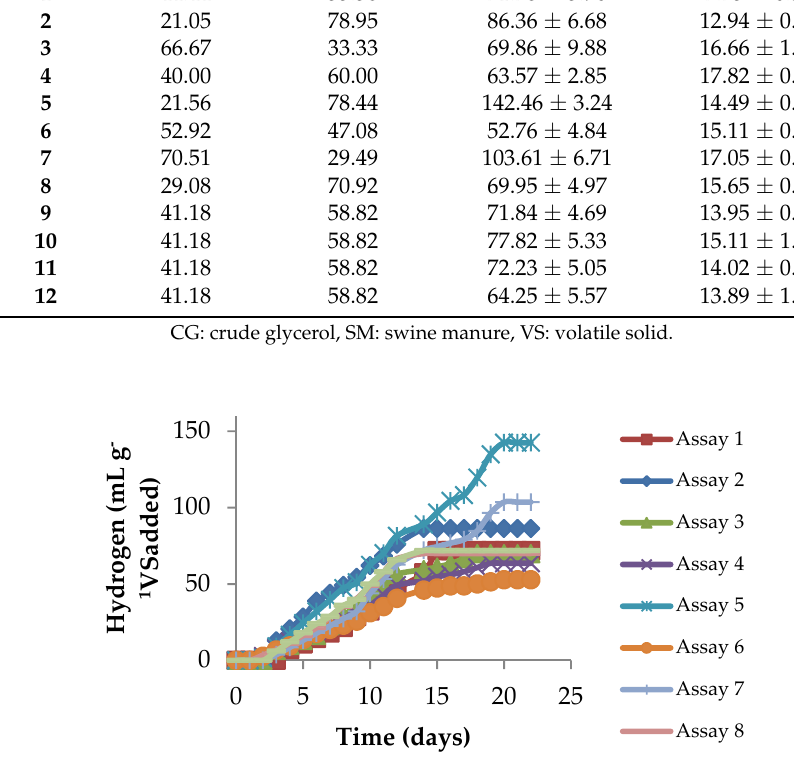
Figure 2. Profile of the hydrogen production tests with 21 day of fermentation of crude glycerol and swine manure. Assay 1 (4.31 g VS L − 1 ); Assay 2 (5.99 g VS L − 1 ); Assay 3 (9.53 g VS L − 1 ); Assay 4 (11.21 g VS L − 1 ); Assay 5 (4.07 g VS L − 1 ); Assay 6 (11.45 g VS L − 1 ); Assay 7 (6.58 g VS L − 1 ); Assay 8 (8.95 g VS L − 1 ); Assay 9 (7.76 g VS L − 1 ). Table 4. Final parameters from the fermentative process, carried out on assays with different concentrations of crude glycerol and swine manure.